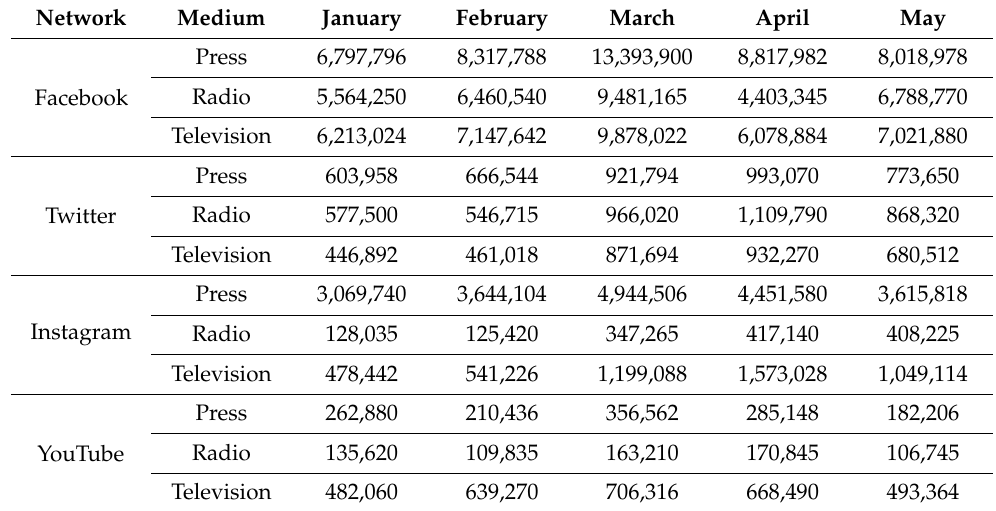
Table 6. Response rate to messages sent in the period of